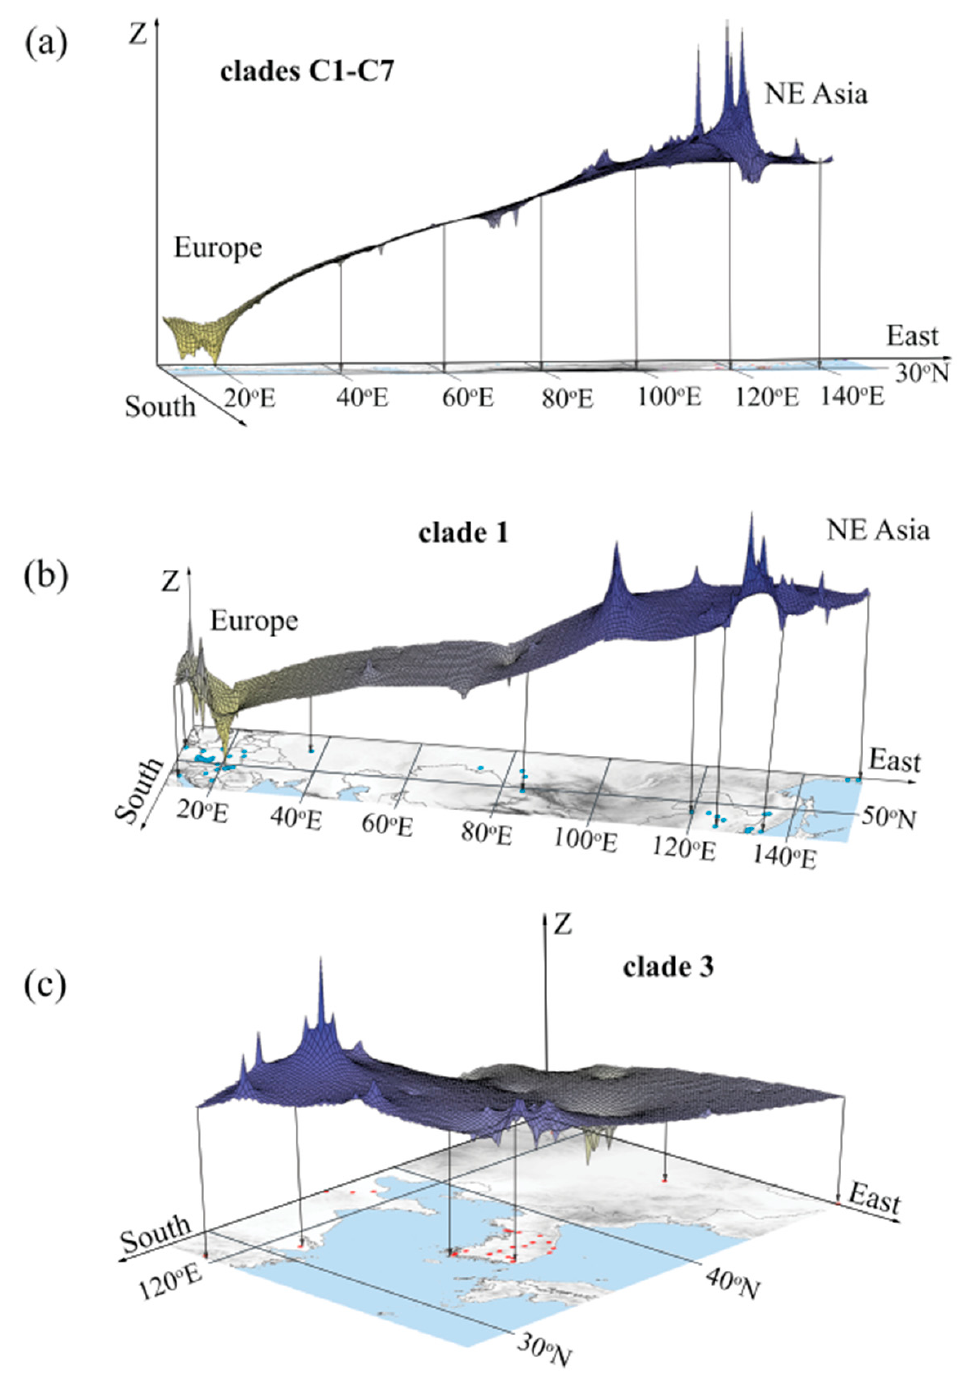
Figure 3. Spatial genetic divergence of A. agrarius in Eurasia ( a ) and within clades C1 ( b ) and C3 ( c ), visualized using the Landscape Shape Interpolation tool in Allele In Space, with three-dimensional surface plots. Surface plot heights (Z) reflect genetic distances between the corresponding